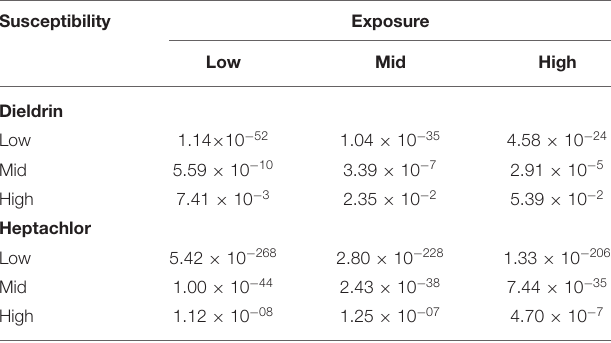
TABLE 3 | The probability of occurrence of health effects (unitless) resulting from a virtual individual’s exposure to dieldrin and heptachlor, calculated based on low, mid, and high levels of human exposure and toxicological